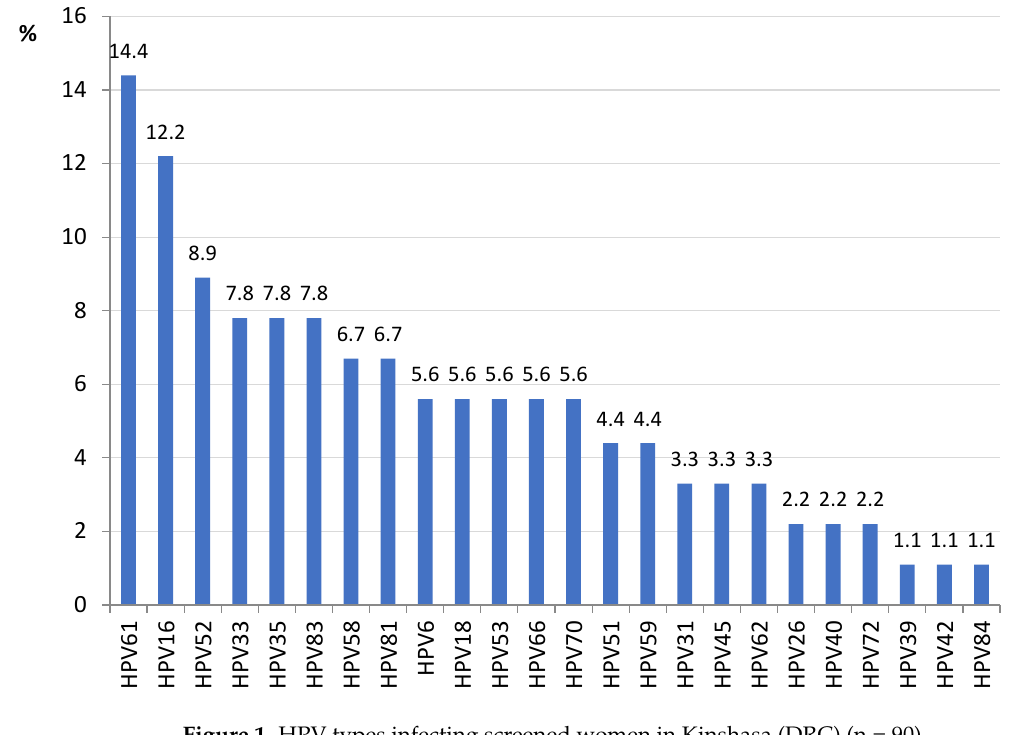
Figure 1. HPV types infecting screened women in Kinshasa (DRC) (n = 90). The distribution of HR-HPV among participants showing LSIL (CIN-1) is shown in Figure 2. HPV33 (17.1%) and HPV35 (14.6%) were the most frequent types associated with LSIL, followed by HPV16 and HPV58 (9.8%). Among participants with HSIL (CIN-2/3), HPV16 was the predominant agent associated with this phase (55.6%) (Figure 3).